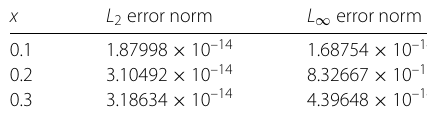
Table 2 L 2 and L ∞ error norms for TFCRDEs by HATM for λ = 1